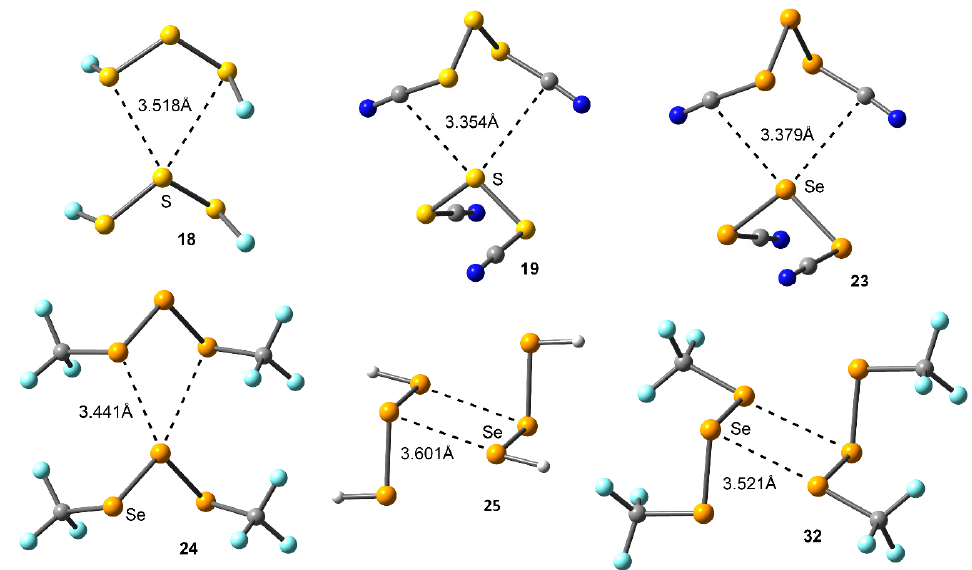
Figure 5. Optimized geometries of some representative complexes at the RI-MP2/def2-TZVPD level of theory.